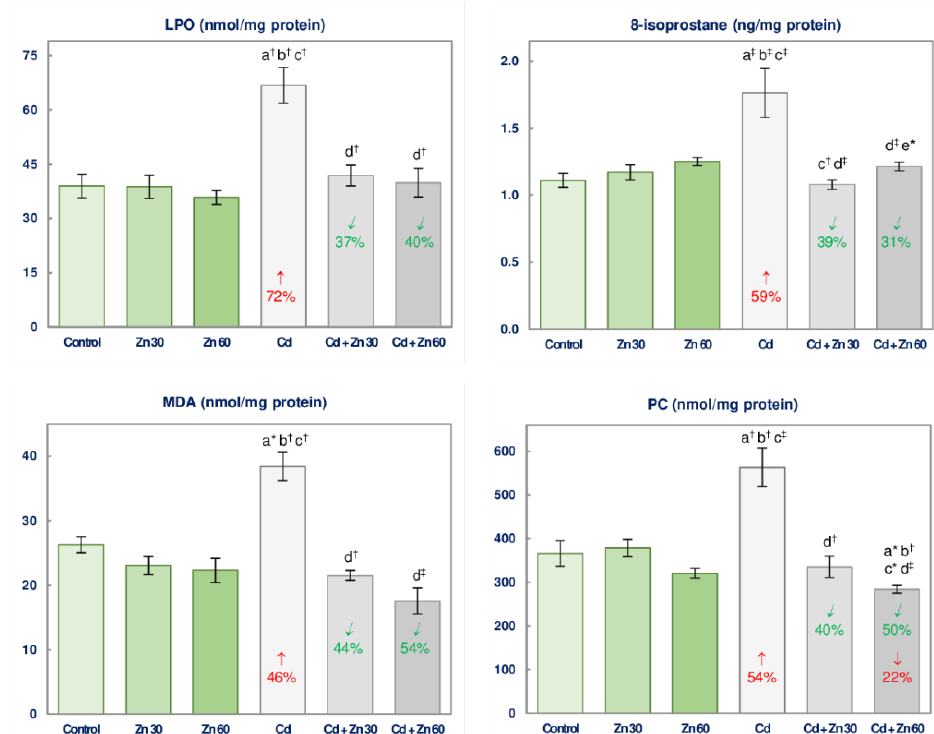
Figure 6. The concentrations of lipid peroxides (LPO), malondialdehyde (MDA), 8-isoprostane, and protein carbonyls (PC) in the brain tissue of male rats after 6-month treatment with cadmium (5 mg Cd/L) and/or zinc (30 or 60 mg Zn/L) via drinking water. Data are shown as mean ± standard error (SE) for 8 animals. Statistically significant differences: a vs. Control group; b vs. Zn 30 group; c vs. Zn 60 group; d vs. Cd group; e vs. Cd + Zn 30 group; * p < 0.05; † p < 0.01; ‡ p < 0.001. The values inside the bars express the percentage changes or folds of changes vs. the control group ( ↓ , decrease; ↑ , increase) or Cd group ( ↙ , decrease).